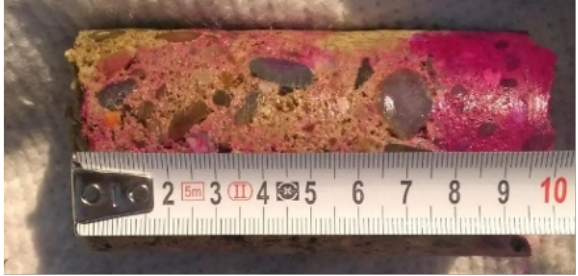
Figure 5. The carbonation depth of concrete at the places where the render was missing - sample selected from the measurements performed in 2018 (Bridge in Sládkovi č ovo).